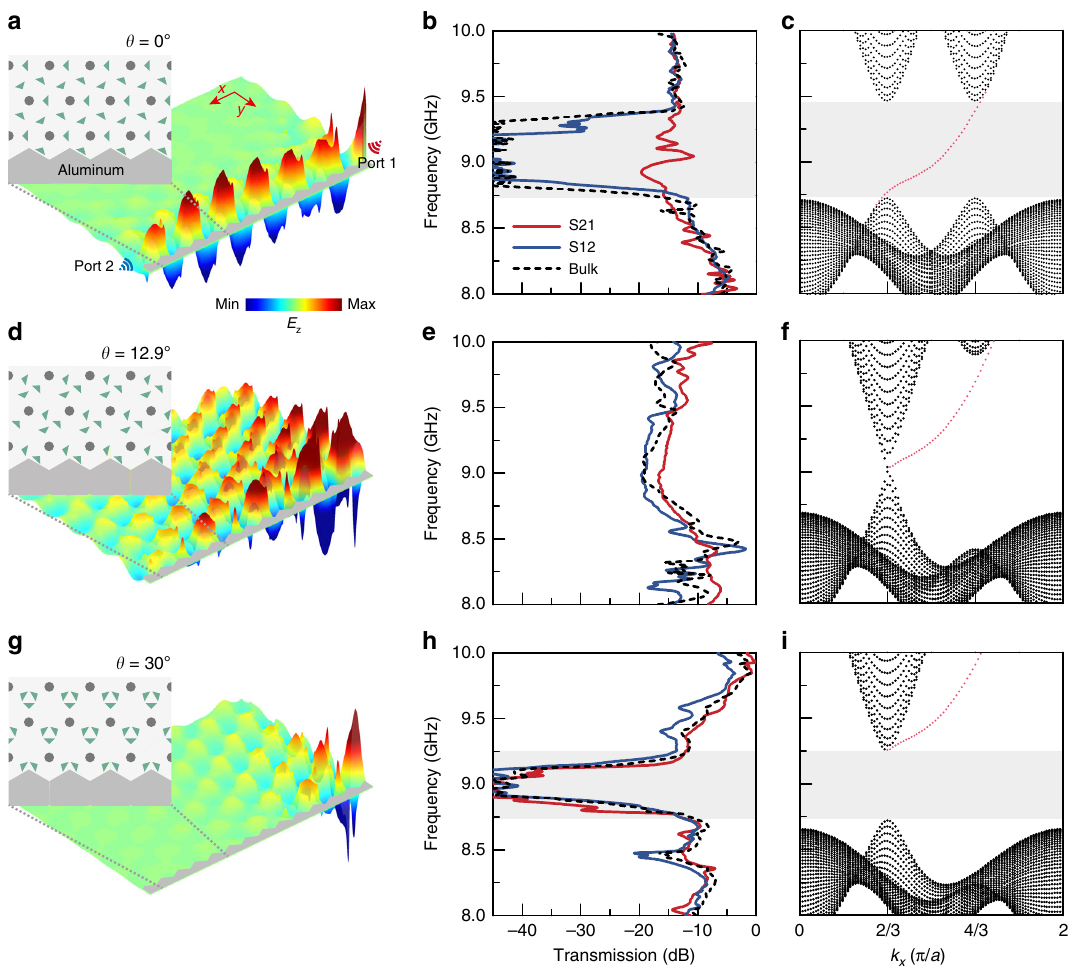
Fig. 2 Observation of an unpaired Dirac point associated with a topological phase transition. The orientation angles are a – c θ = 0° (topologically nontrivial bandgap over 8.72 – 9.47 GHz), d – f θ = 12.9° (gapless), and g – i θ = 30° (topologically trivial bandgap over 8.75 – 9.26 GHz). a , d , g PhC con fi guration, which includes a domain wall, and simulated electric fi eld distribution excited by a 9.0-GHz source at Port 1. b , e , h Experimentally measured normalized bulk and edge transmissions (S-parameter magnitudes). c , f , i Numerically calculated band diagrams for the structures (including domain wall); black dots represent projected bulk states, and the red dots are edge states localized along the boundary. The numerical data from the third column are used to estimate the bandgap